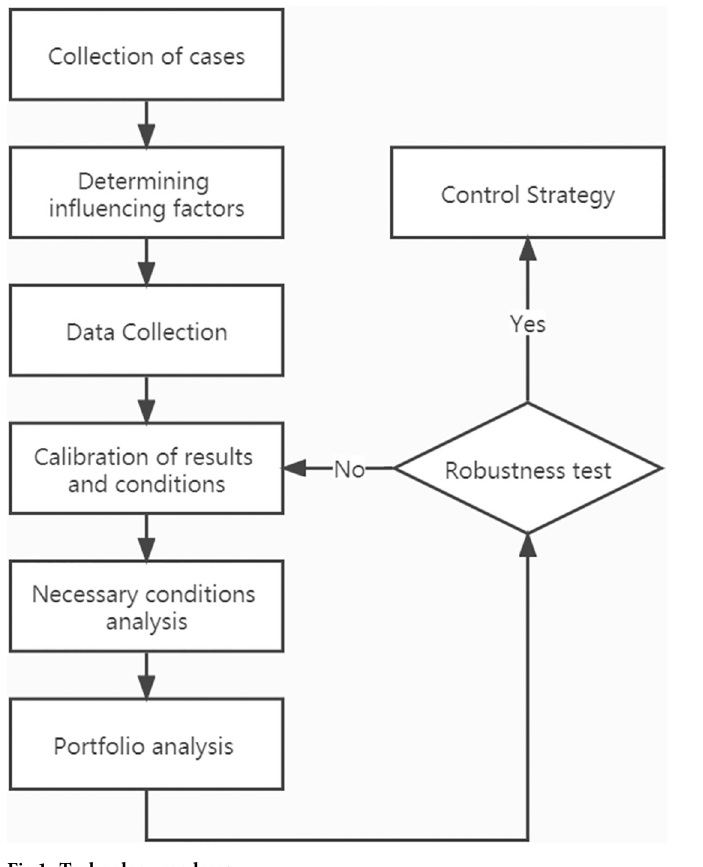
Fig 1. Technology